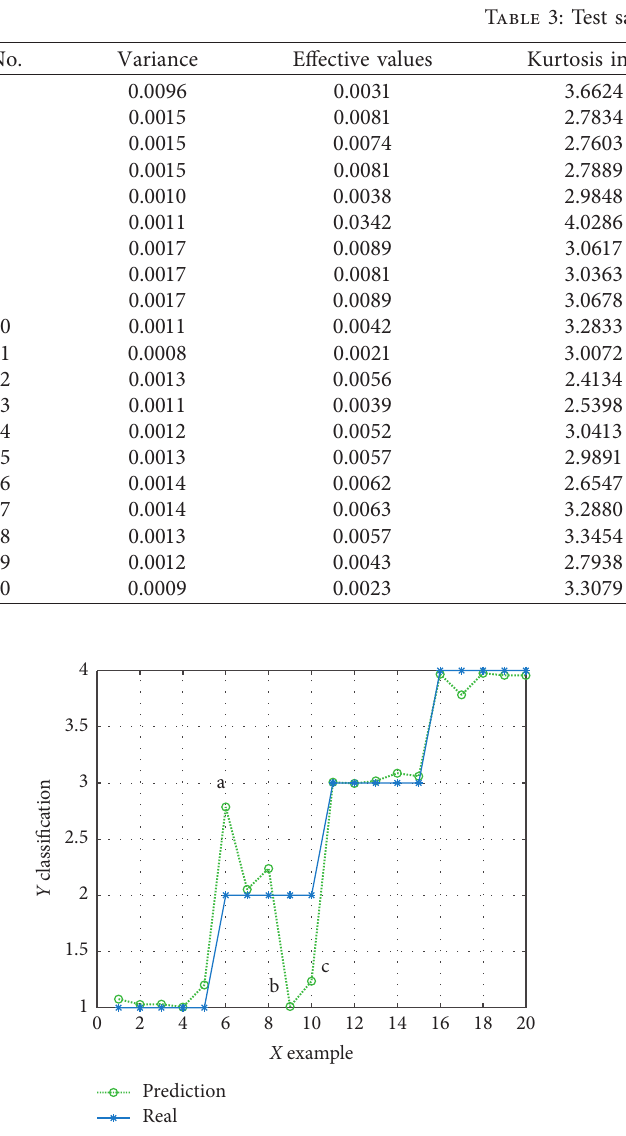
Figure 9: The fitting diagram of GAB network.